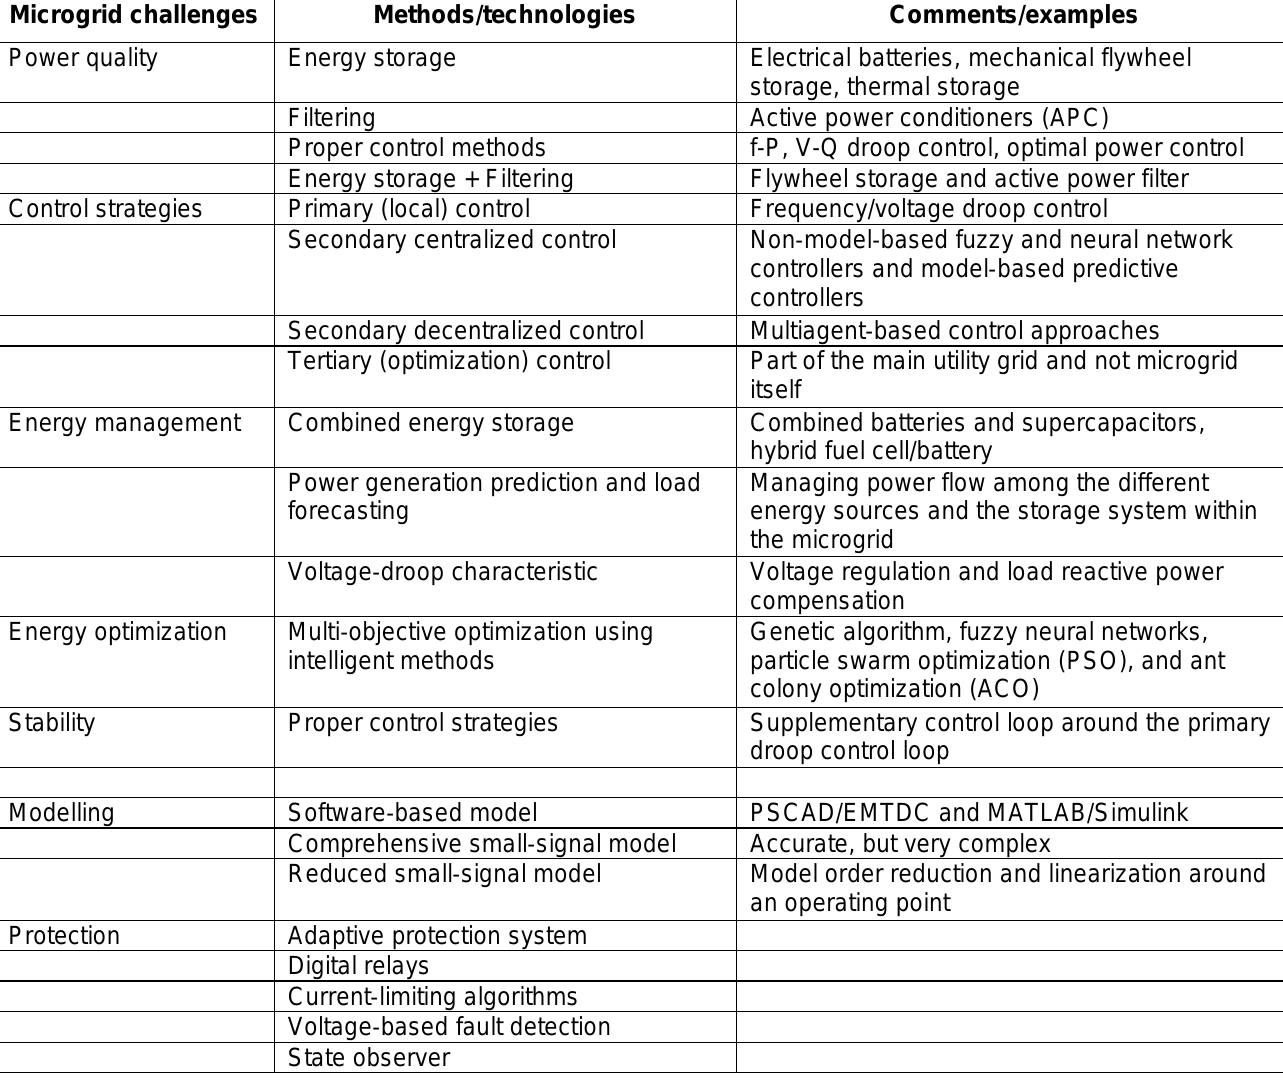
Table 3. Challenges faced in interconnected microgrids and methods to overcome with examples Microgrid